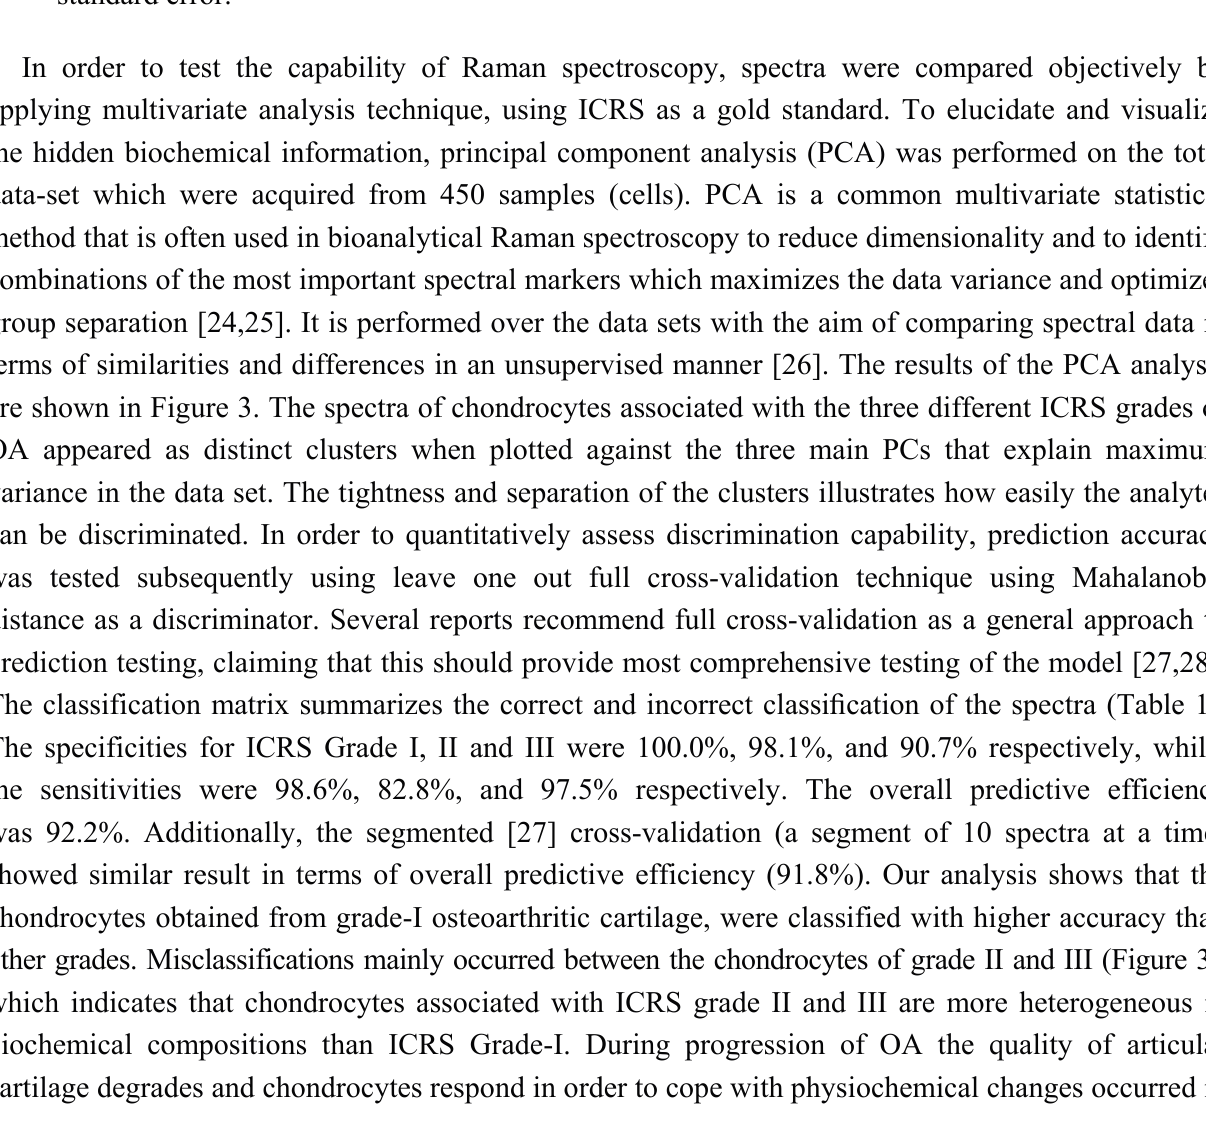
Figure 2. A relative comparison for the content of amide-I ( a ); amide-III ( b ); phenylalanine ( c ); lipid ( d ); and DNA/RNA ( e ) in osteoarthritic chondrocytes ( n = 150 cells). These chondrocytes were isolated from osteoarthritic cartilage section of ICRS Grade-I, II and III. Data represents the normalized mean area of Raman band and bar represents the standard